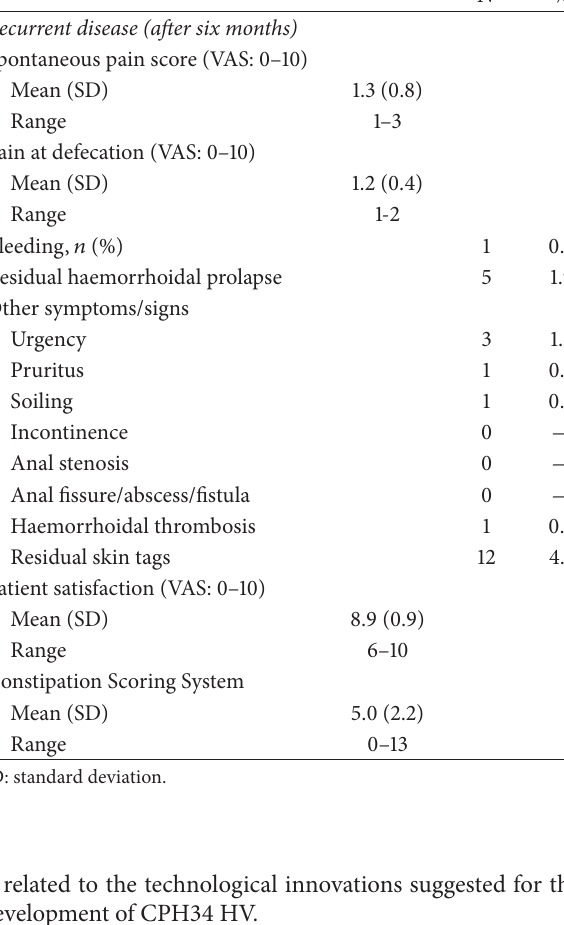
Table 5: Follow-up at 12 months in 254 patients. 𝑁 %